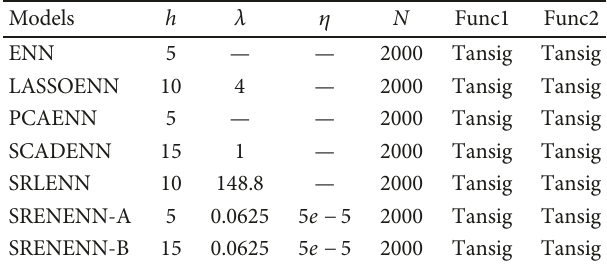
Table 2: Parameter values of seven forecasting models at six